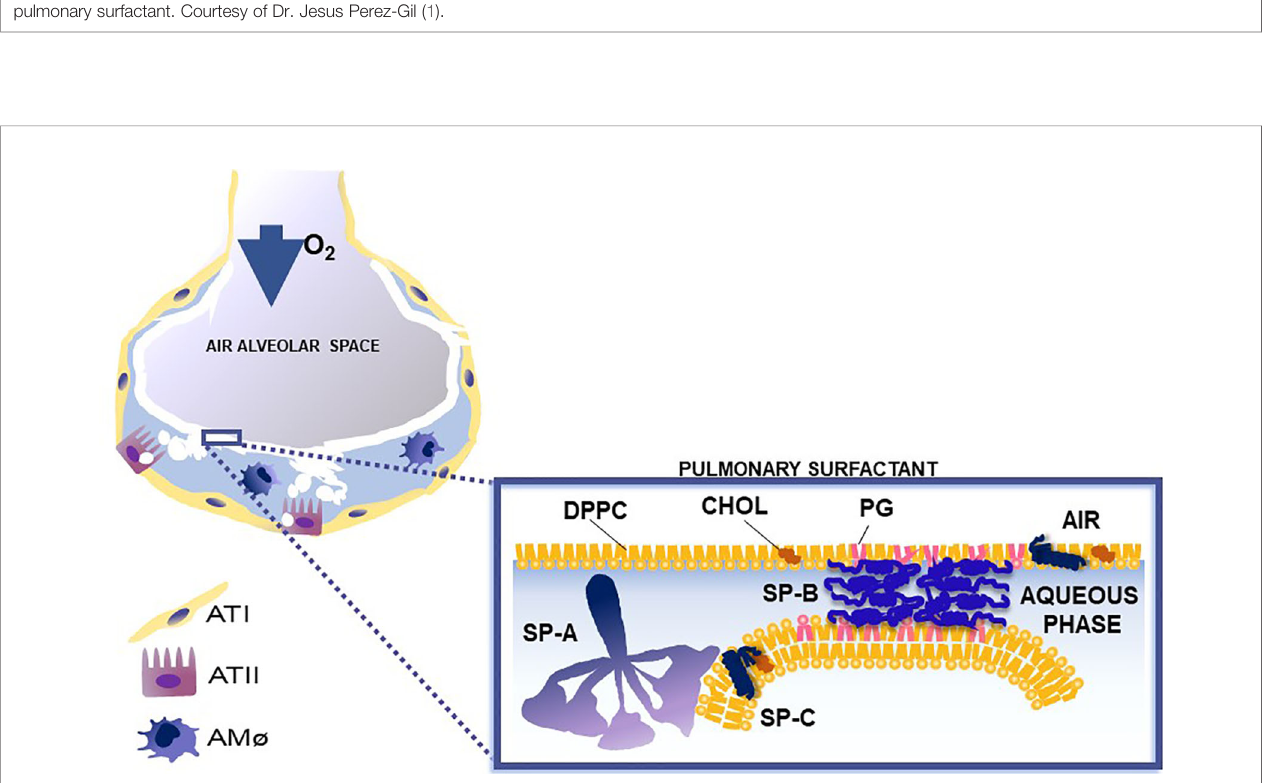
FIGURE 2 | This cartoon depicts the role of surfactant proteins (SP-A, SP-B, and SP-C) in the biophysical properties of surfactant. Courtesy of Dr. Jesus Perez-Gil (1).